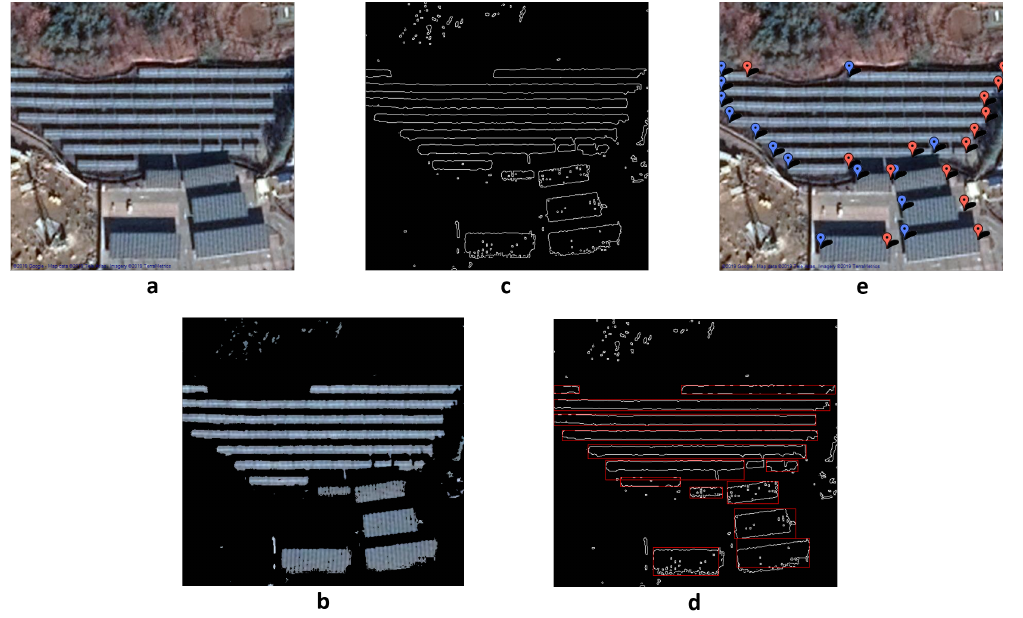
Figure 7. ( a ) Image from Google maps; ( b ) segmented image; ( c ) detected contours; ( d ) filtered contours; and ( e ) final image with